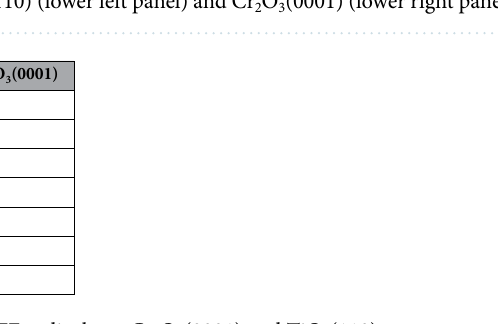
Table 1. Adsorption energy of defluorinated TFE radicals on Cr 2 O 3 (0001) and TiO 2